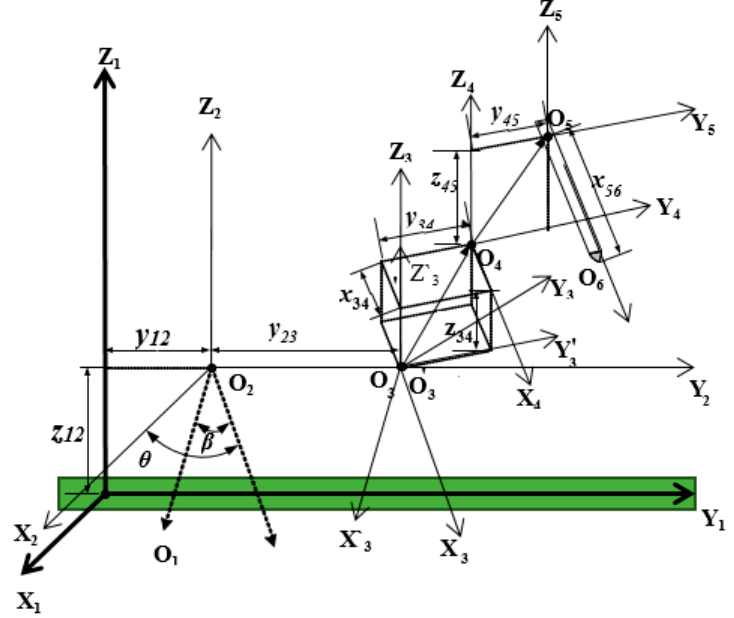
Figure 4. The coordinate systems of the cross slider and welding carriage.